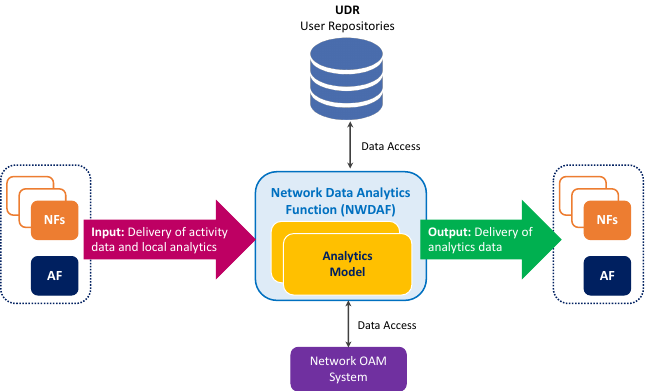
Figure 2. Architecture of Network Data Analytics